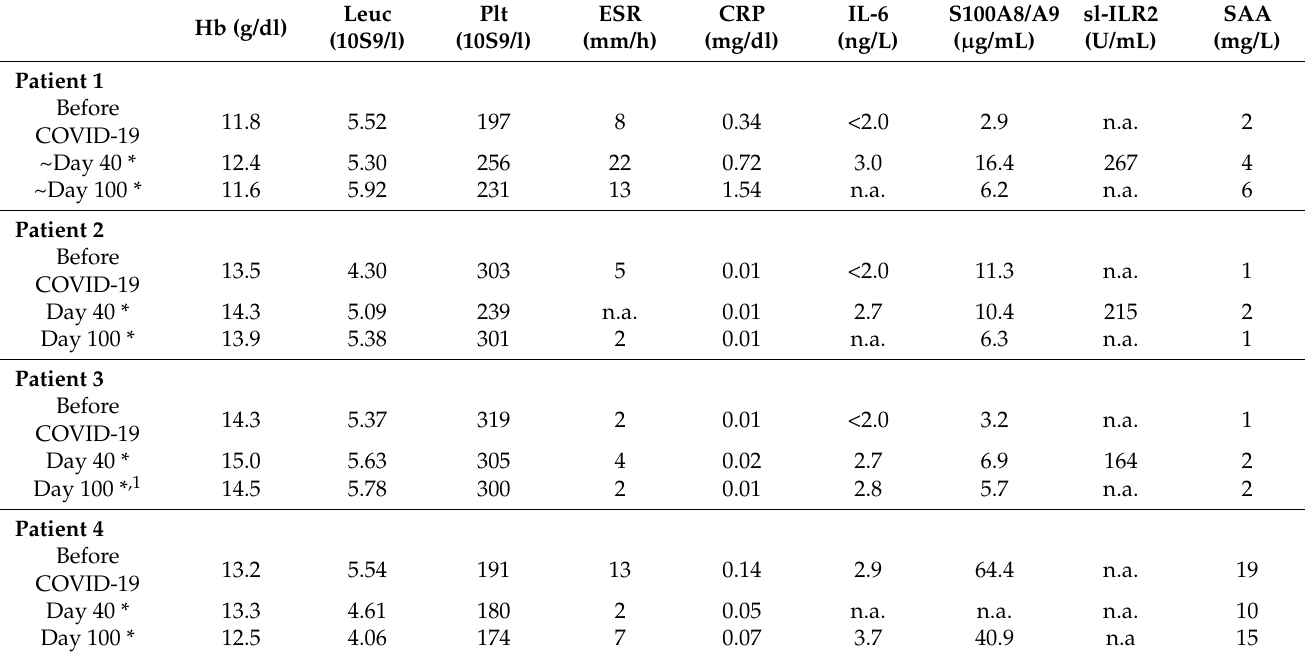
Table 2. Laboratory results before and after COVID-19 symptom